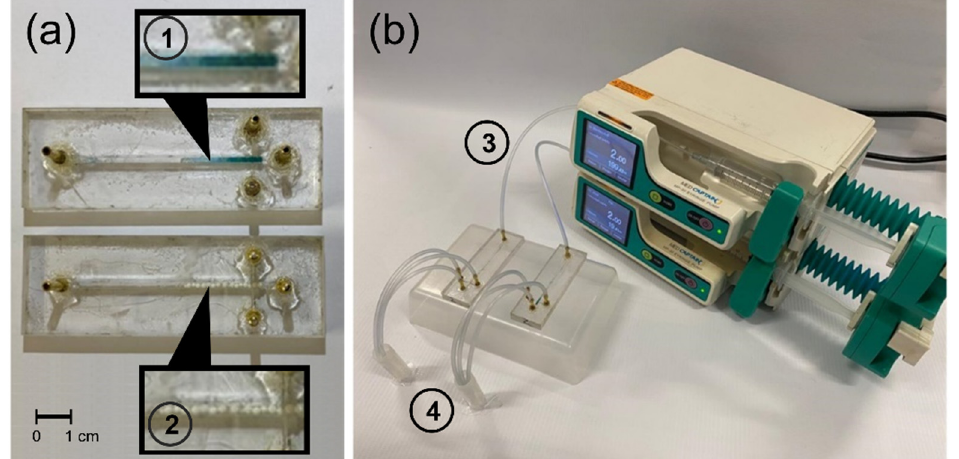
Figure 2. Experimental setup for wastewater treatment. ( a ) Microreactors for acetaminophen treat ‐ ment filled with ① Laccase ‐ alginate microcapsules and ② Laccase ‐ Al 2 O 3 pellets up to 2 cm of the main microchannel. ( b ) Assembly carried out for wastewater treatment. ③ Wastewater samples were pumped through the inlet and ④ treated water was collected at the end of each